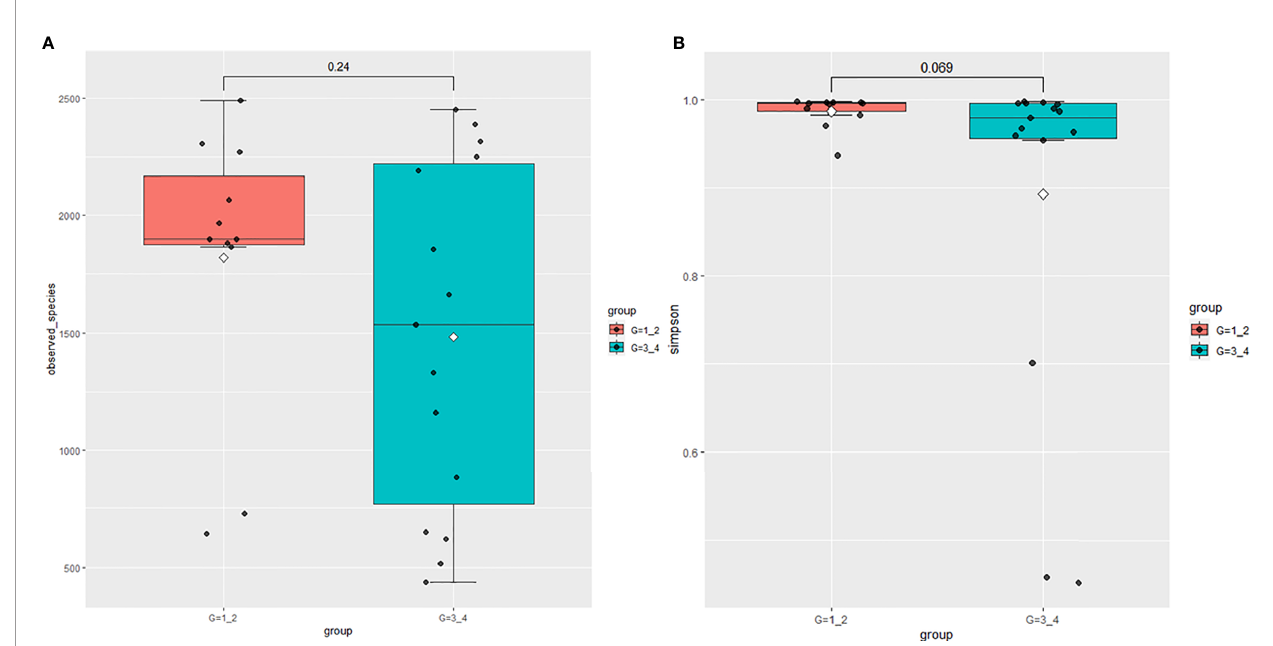
FIGURE 1 | Microbial alpha diversity of urine samples. (A) Observed Species, (B) Simpson